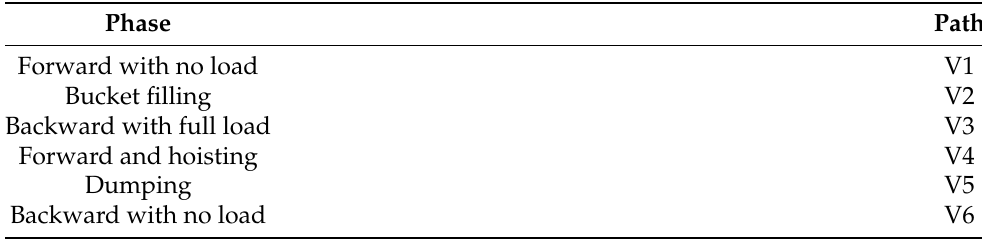
Figure 1. V-cycle of wheel loaders. Table 1. V-cycle